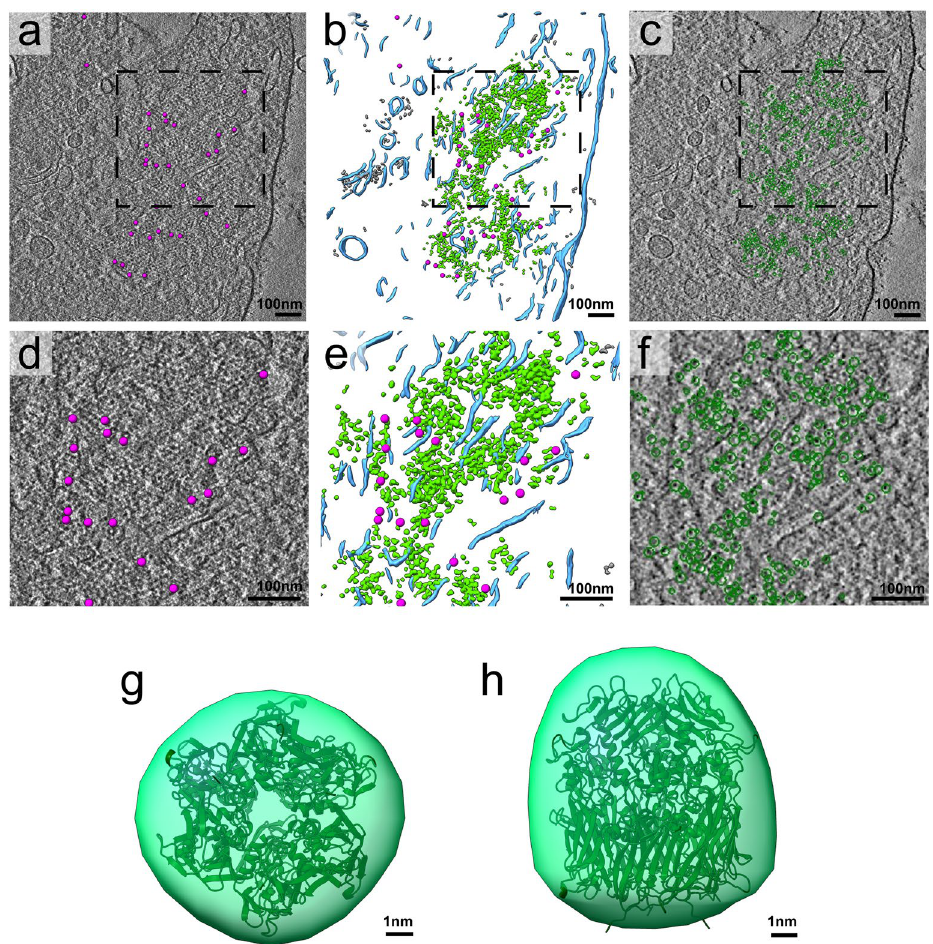
Figure 5. D13 trimers fail to form hexamers the absence of H7 synthesis and clusters together with membranes. HeLa cells infected for 12 h with VACVindH7 without IPTG ( a – f ) were processed for cryo-sectioning, thawed cryo-sections immuno-labeled with anti-D13 and protein A coupled to 10 nm gold, followed by plunge freezing. In ( a ), a single slice of the tomographic volume is shown (slice 43, voxel size = 12.67A), the gold beads localized in the initial slices of the volume have been marked on top using magenta spheres of 10 nm in size. In ( b ) the tomographic volume annotations are presented as follows: membranes are shown in light blue, gold beads in magenta, D13 trimers in green. Densities recognized along the D13 trimeric particles by the application of the CNN trained algorithm that are located outside the D13 cluster are displayed in grey. In ( c ) the slice number 50 of the same volume is displayed. Here the green circles indicate the particles that are picked for the generation of the initial averaged model. In ( d – f ) a zoom of the respective boxed areas of ( a – c ). In ( g , h ) two perpendicular views (bottom and side view) of the initial D13 model in green superimposed to the crystal structure of the D13 trimer (dark green ribbons, PDB id